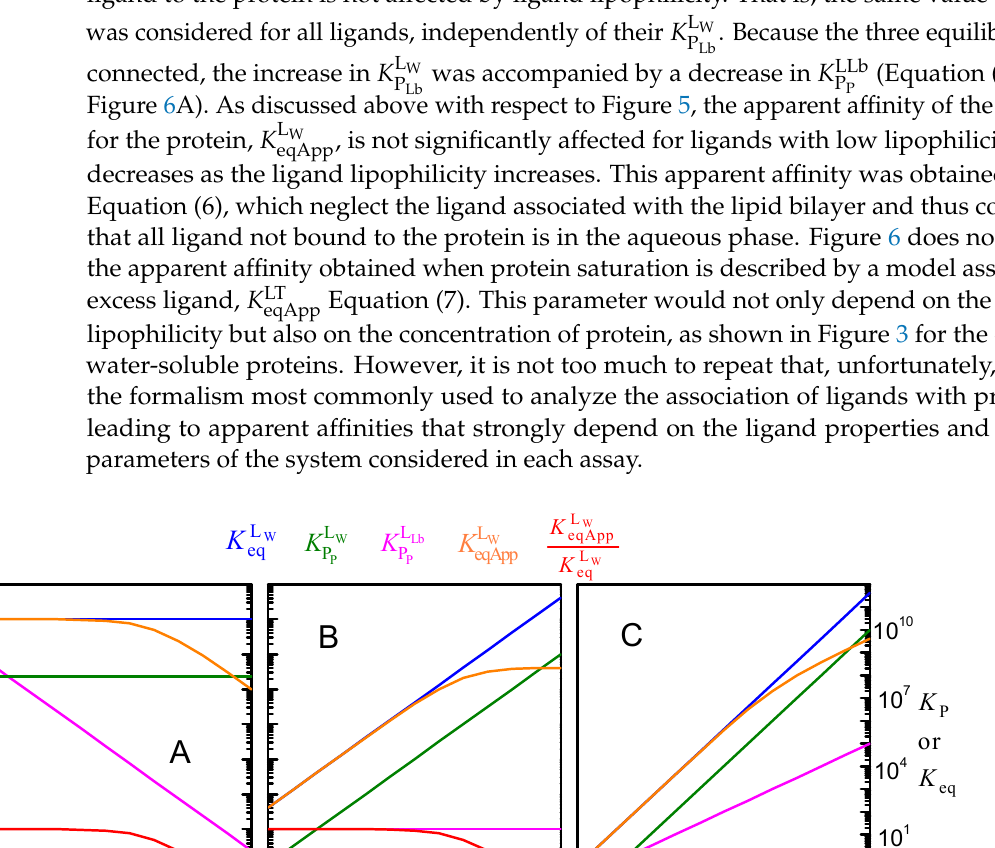
L K = 10 6 M − 1 , plot ( A )), that the relative affinity for the eq = 1, plot ( B )), or that the affinity for the protein L P P K = 1, plot ( B )), or that the affinity for the protein (cid:16) (cid:1)(cid:17) 2 P = (cid:0) K LLw K LLw = 1, plot ( C )); for P T = 1 µ M, P P P PLb ( ) ( ) 2 L L Lw Lw K K = = 1, plot ( C )); for P T = 1 μ M, M W P P LbP